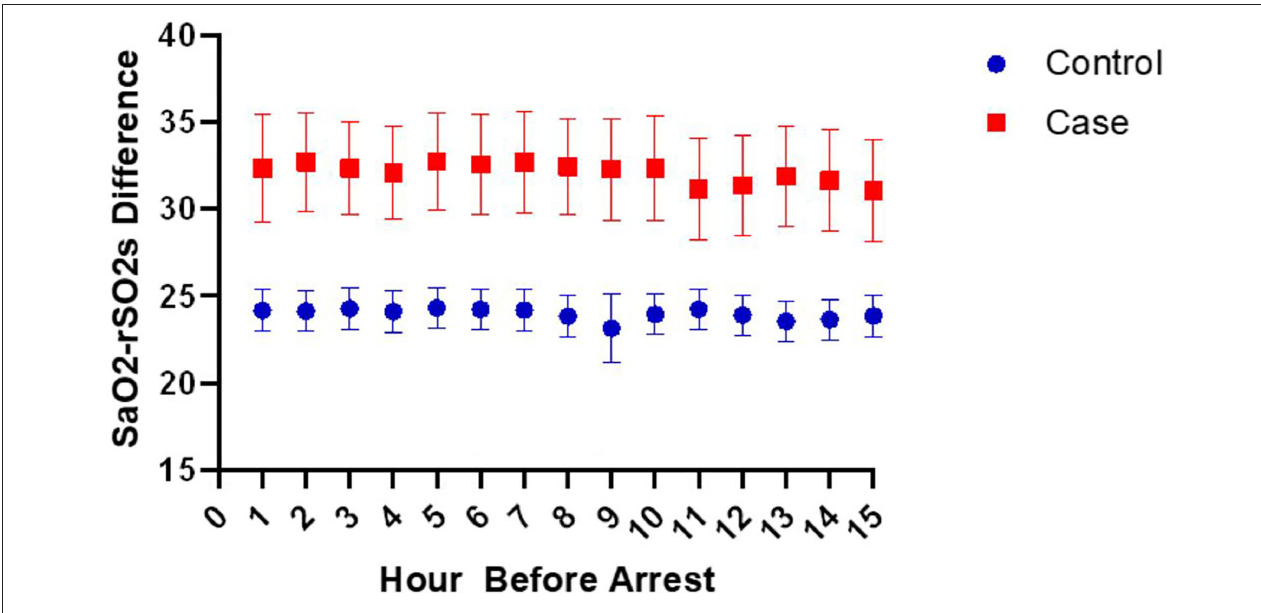
FIGURE 2 | Changes in the SaO2-rSO2s difference over time.